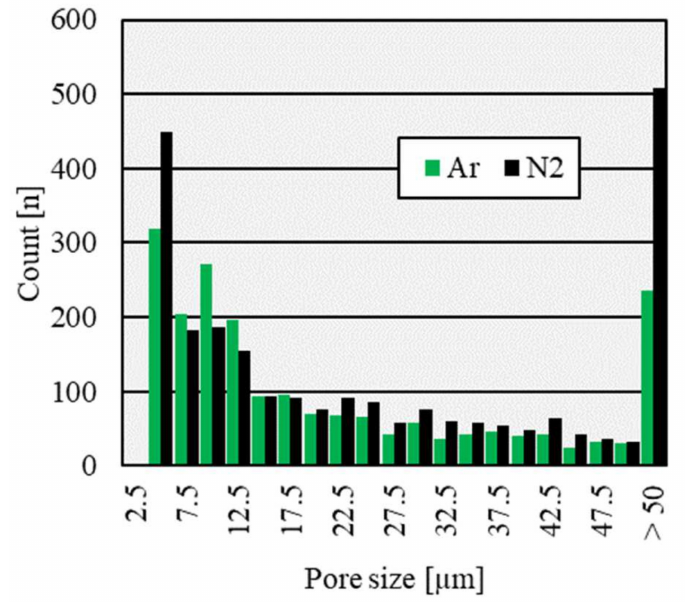
Figure 5. Histogram of pore size in the AB condition for specimens produced under an argon and nitrogen protective